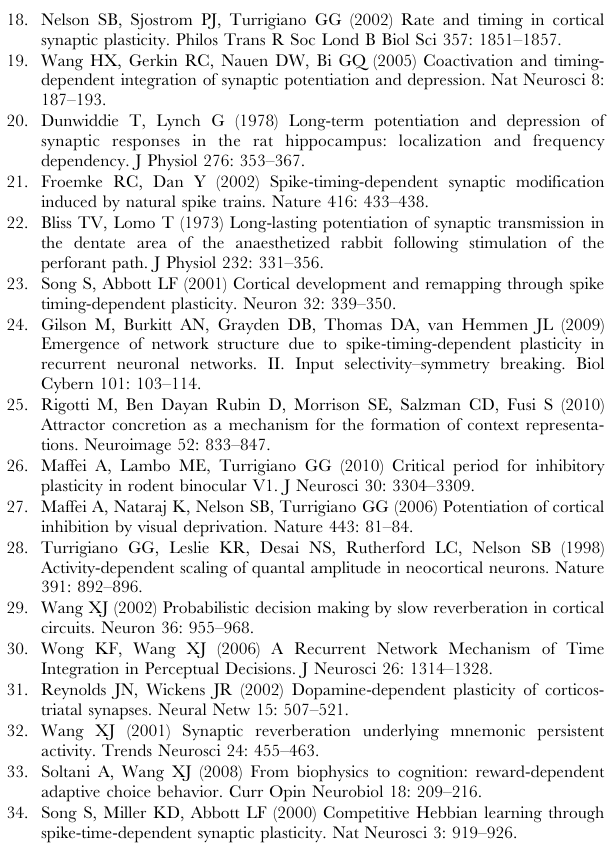
Figure S9 Network mean stimulus-pair selectivity - Varying the voltage threshold for induction of LTPi. Each matrix contains the